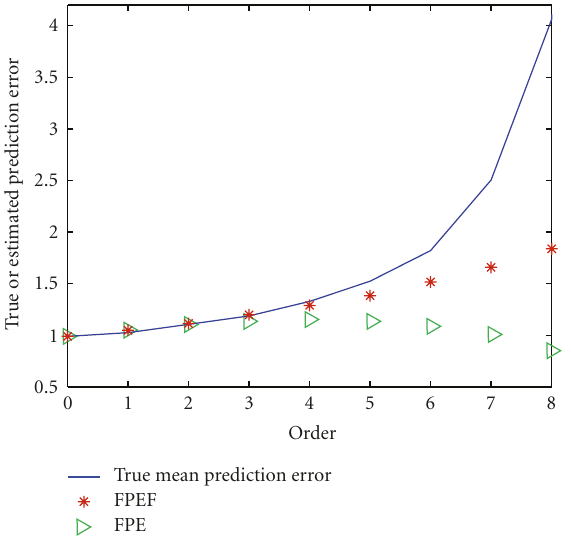
Figure 3: Estimation of prediction error for simulated AR(2) sequence with N = 19.